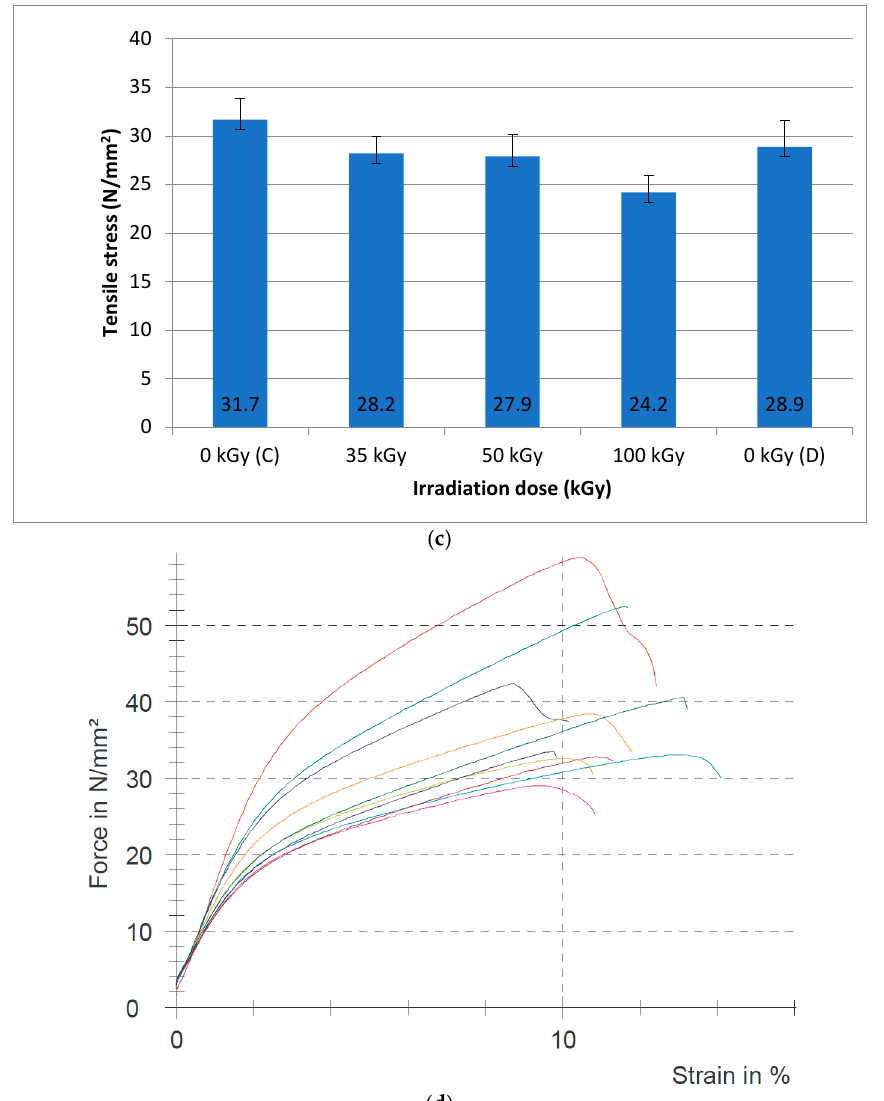
Figure 5. Tensile stress mean values of gamma-irradiated samples: ( a ) interval 1 results from control batch A to B; ( b ) interval 2 results from control batch B to C; and ( c ) interval 3 results from batch C